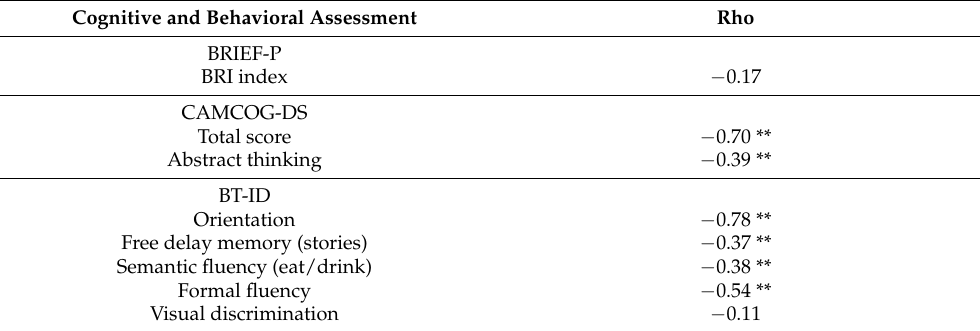
Table 6. Correlations between GDS-DS stages and cognitive/behavioral